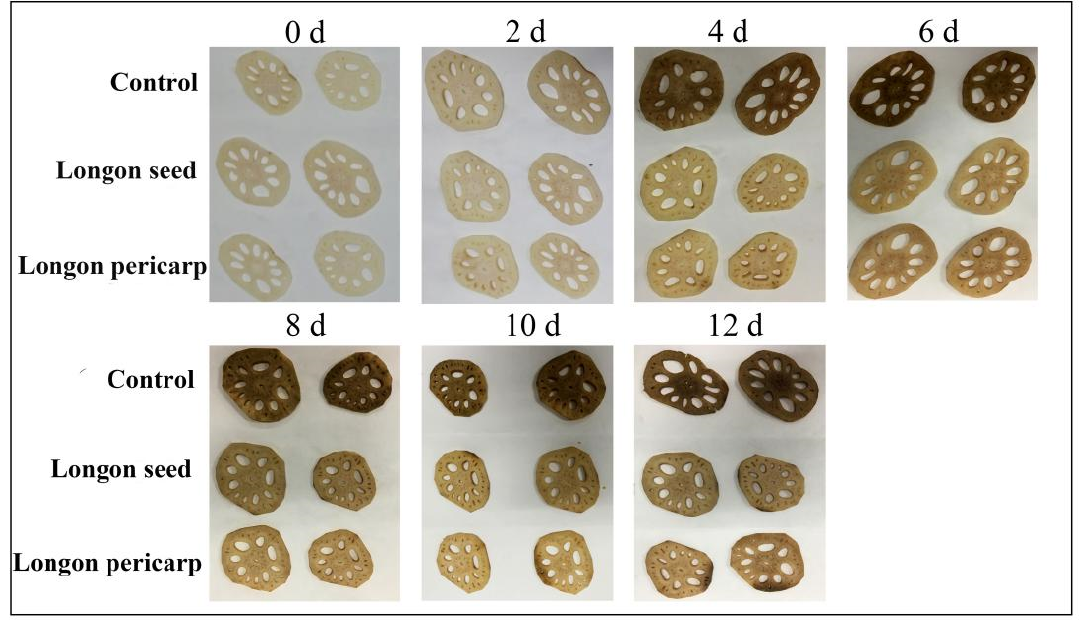
Figure 4. Apparent changes in fresh-cut lotus roots treated with different solutions during storage for 12 days at 4 ◦